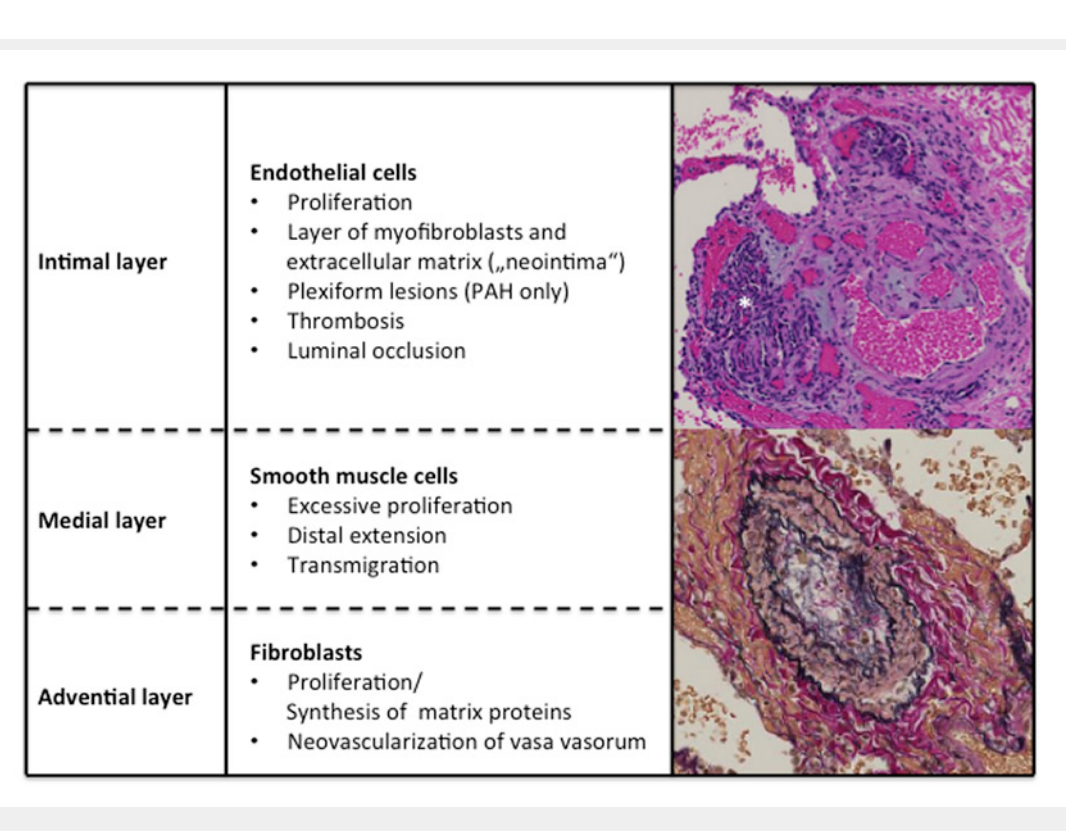
Features of pulmonary artery vascular remodelling in different cell types. All vascular cell types (endothelial cells, smooth muscle cells and adventitial fibroblasts) are involved in pulmonary artery remodelling and are characterised by excessive proliferation. The accumulation of myofibroblasts and extracellular matrix proteins within the endothelial layer is termed “neointima”. Plexiform lesions (shown by white star) are a system of thin-walled, dilated vessels as consequence of endothelial proliferation. These lesions are found exclusively in pulmonary arterial hypertension (PAH). The most prominent changes are observed within the vessel’s medial layer and mediated by a imbalance between proproliferative and apoptotic activity of smooth muscle cells and transmigration of these cells and myofibroblasts in the endothelial layer. Within the adventitial layer, neovascularisation of vasa vasorum and increased production of matrix proteins is observed (shown by Elastin-Van Gieson (EVG) staining). These alterations result in excessive hyperplasia, increased vessel thickness and luminal occlusion (reviewed in